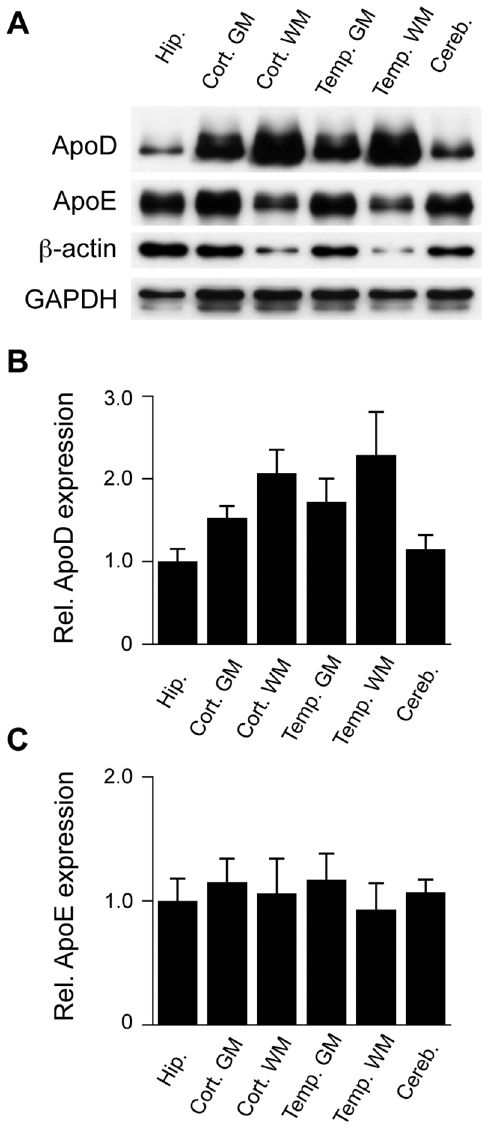
loading. Levels of β -actin were similar across the brain regions and were therefore used as a housekeeper control protein to normalize apoD and apoE expression. Representative blots are shown from a healthy 68 year-old male subject (A). Histograms indicate the relative expression of apoD (B) and apoE (C), corrected for β -actin levels. Data in “ B ” and “ C ” are relative optical density measurements where the hippocampus is arbitrarily defined as 1.0. The data are derived from 3 different individuals (mean values, SE shown by the error bars). Hip., hippocampus; Cort., frontal cortex; GM, grey matter; WM, white mater; Temp, temporal cortex; Cereb,